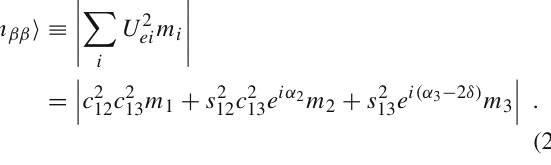
Fig. 4 The prediction for the effective Majorana neutrino mass (cid:3) m ββ (cid:4) as a function of θ 23 in the minimal gauged U ( 1 ) L μ − L τ model. The dark (light) red band shows the uncertainty coming from the 1 σ (2 σ ) errors intheparametersotherthan θ 23 .Theentireregioniswithinthe2 σ range of θ 23 , while its 1 σ range is between the thin vertical dotted lines. We also show the strongest limit from KamLAND-Zen, (cid:3) m ββ (cid:4) < 0 . 061 eV, in the black dashed line